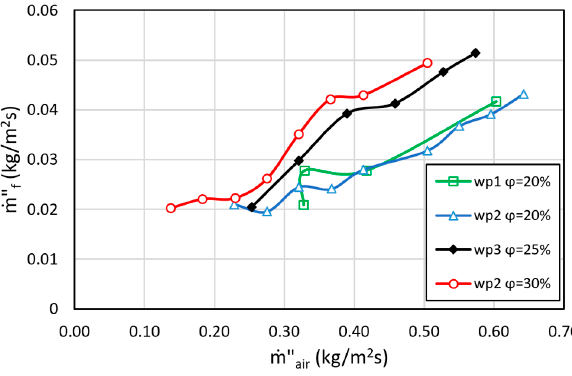
Figure 4. Burning rate versus total airflow for different air configurations.